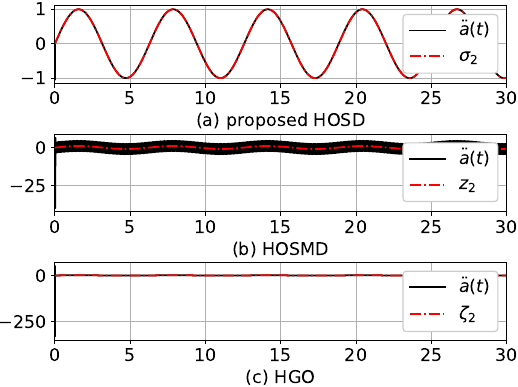
Figure 7. Estimations of ¨ a using parameter set 3 (cid:13) in Table